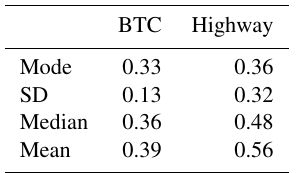
Table 5. Fitting parameters of the lognormal distributions of the fossil-fuel-related emission factor (EF, g(kgfuel) − 1 ) at BTC (all data) and the highway. The distributions are normalized to 1. The derived median and mean are also